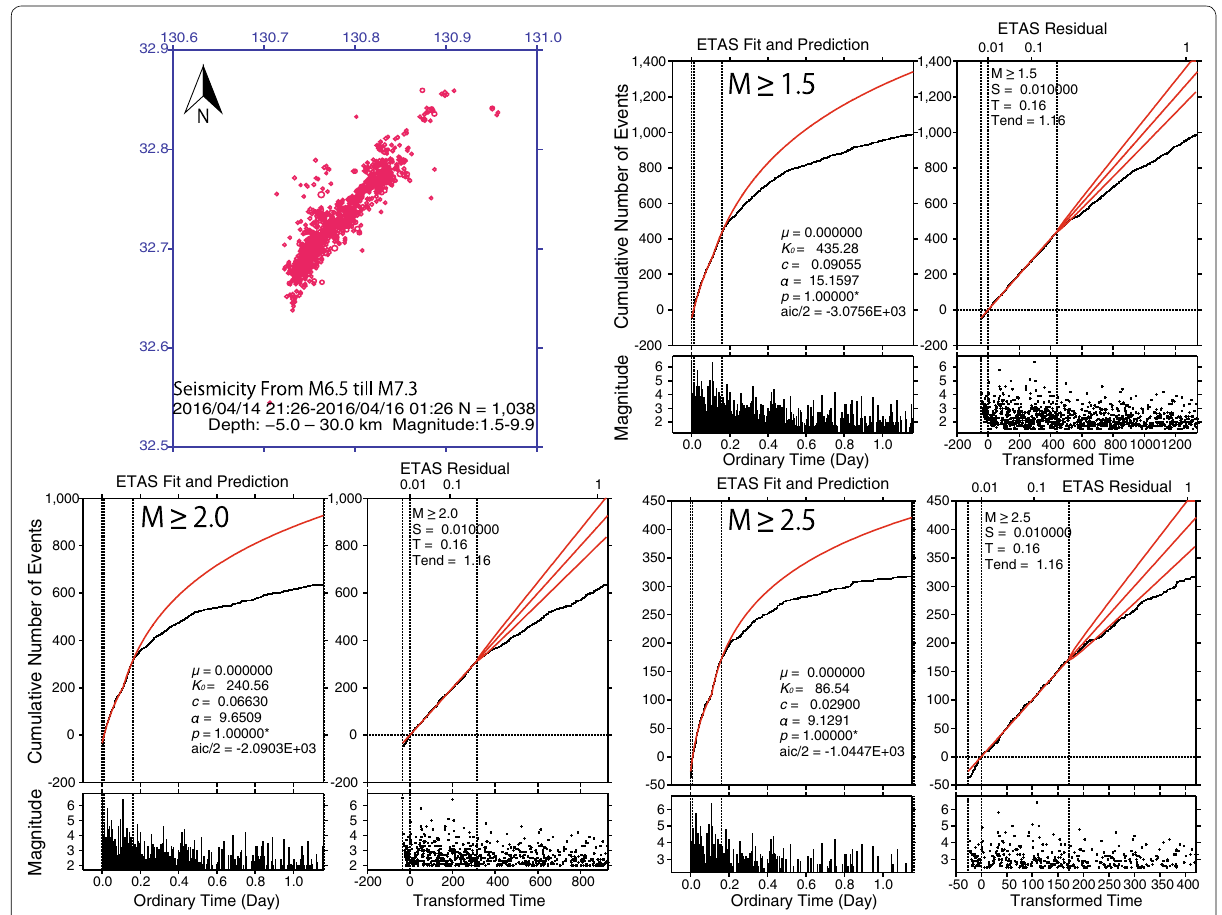
Fig. 5 ETAS model fitted to the foreshock sequence. ETAS model (1) is applied to the aftershock sequence of the M6.5 earthquake prior to the occurrence of the M7.3 mainshock, plotted against the ordinary and transformed times via the theoretical cumulative curve of the ETAS model. The red theoretical cumulative curves are superimposed on the black empirical cumulative curves of the aftershocks of M together with the corresponding M–T